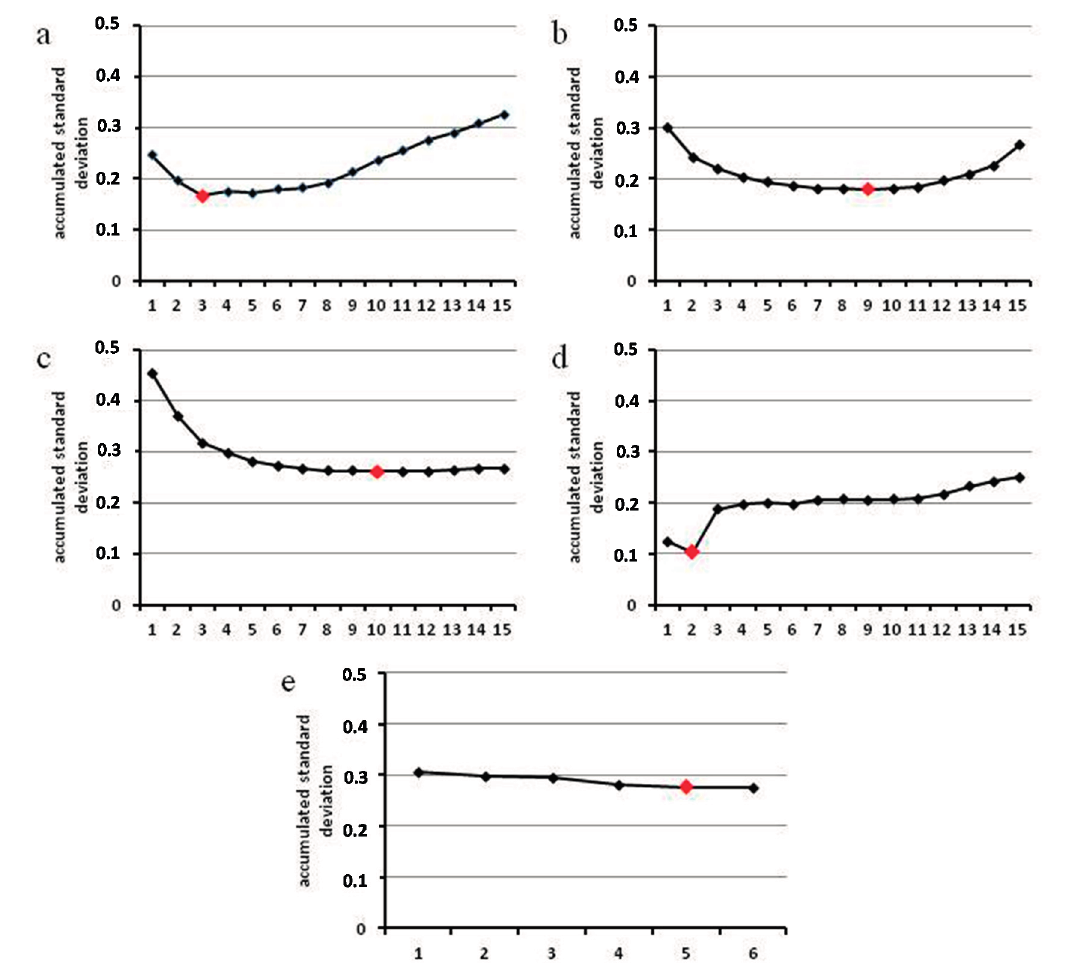
Figure 5. Number of reference genes recommended by NormFinder (optimal number marked red); ( a ) for P. pachyrhizi in vitro structures; ( b ) for P. pachyrhizi in planta structures; ( c ) for all P. pachyrhizi samples; ( d ) for all P. pachyrhizi samples excepting spore and appressorium; ( e ) for G. max